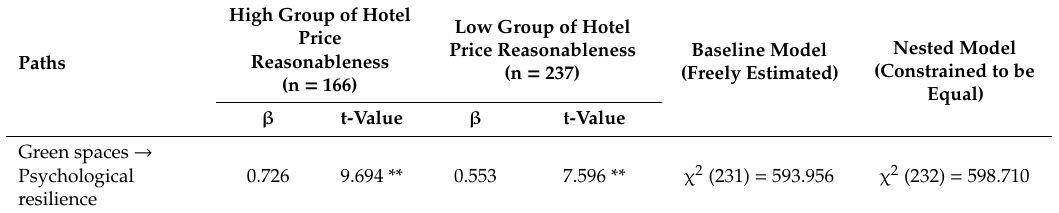
Table 5. Baseline model estimation and invariance test